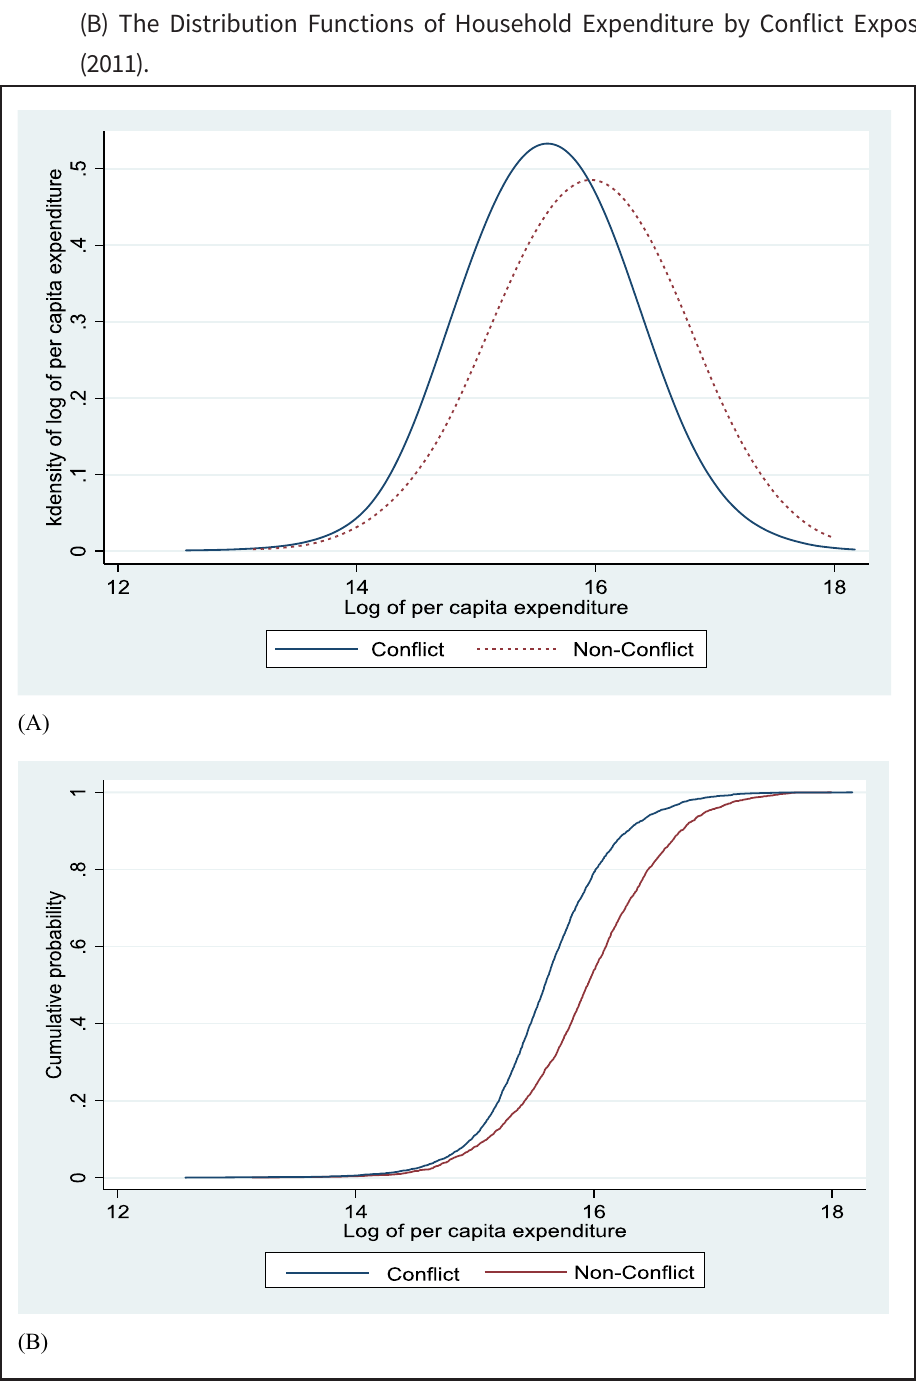
(A) The Density Functions of Household Expenditure by Conflict Exposure (2011). (B) The Distribution Functions of Household Expenditure by Conflict Exposure